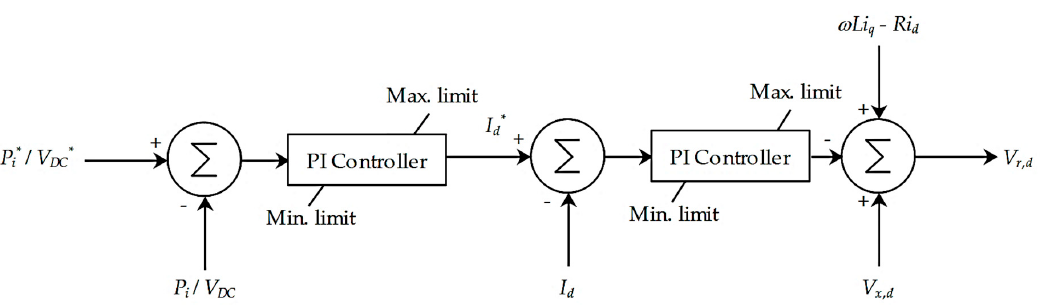
Figure 3. The complete block diagram of the active power flow and DC voltage controllers.